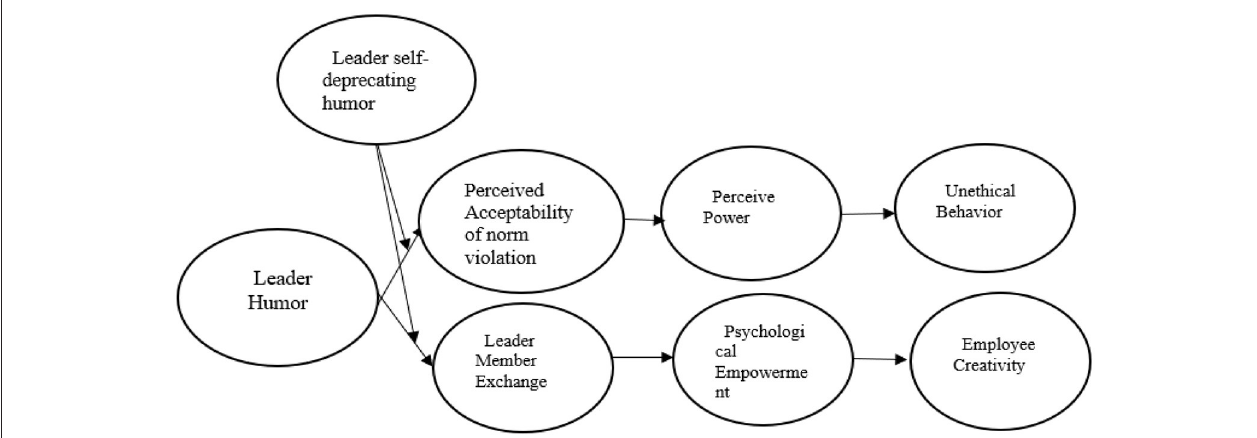
FIGURE 1 | Framework of current study. In this figure, perceived acceptability of norm violation and perceived power are sequence mediation between leader humor (LH) and unethical behavior (UB) (curse path), while LMX and PE are also sequenced mediation between LH and employee creativity (blessing path). Moreover, the self-deprecating humor of the leader (LSDH) plays the role of a moderating variable.